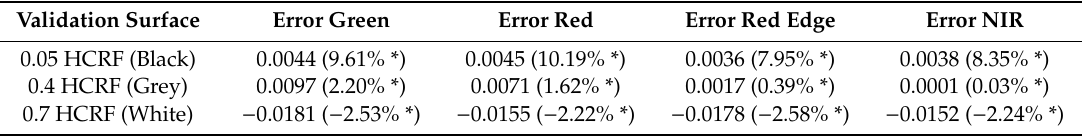
Table 4. Bias and relative errors of the HyPlant HCRF for the Sequoia band spectral ranges over three differently reflective validation surfaces (tarps).